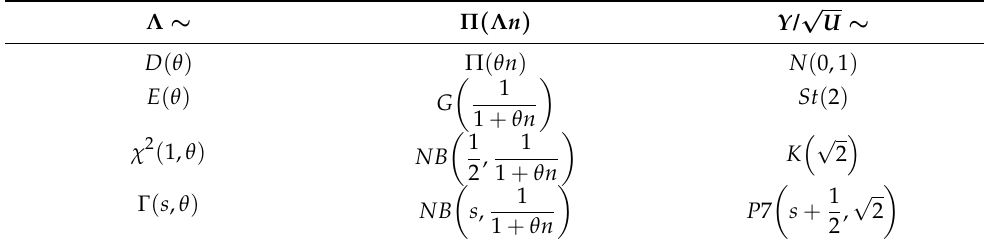
Table 1. Special cases of the limit